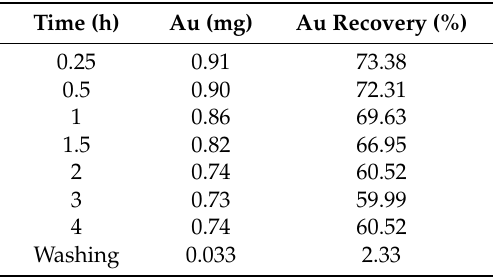
Table 2. Gold recovery obtained with a ammoniacal leaching solution having the following composition: 2 M S 2 O 32 − , 0.1 M CuSO 4 and 4 M NH 3 .